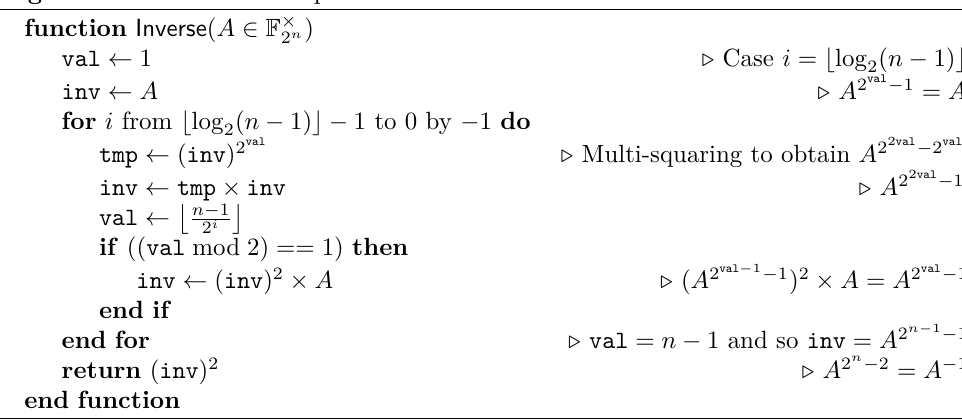
Algorithm 5 ITMIA for a specific addition